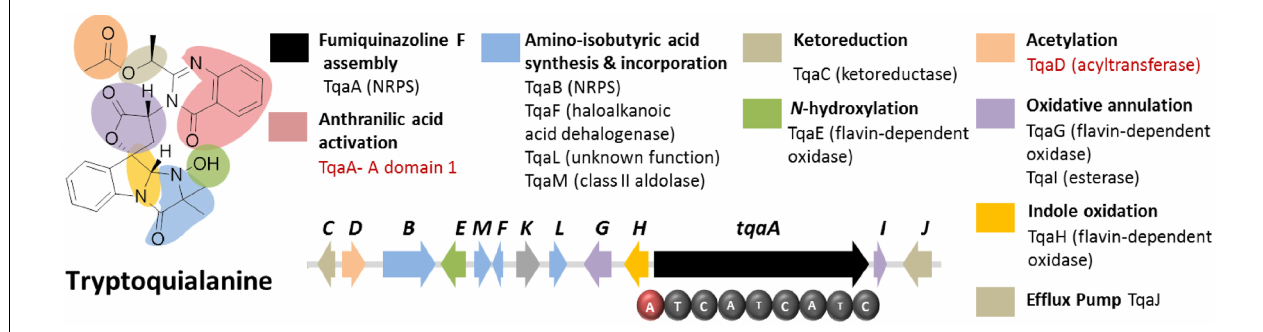
FIGURE 6 |Tryptoquialanine biosynthetic gene cluster in P. aethiopicum . The presence of acyltransferase gene tqaD and the anthranilic acid-activating A domain ofTqaA (in red text) were clues to identification of the cluster.